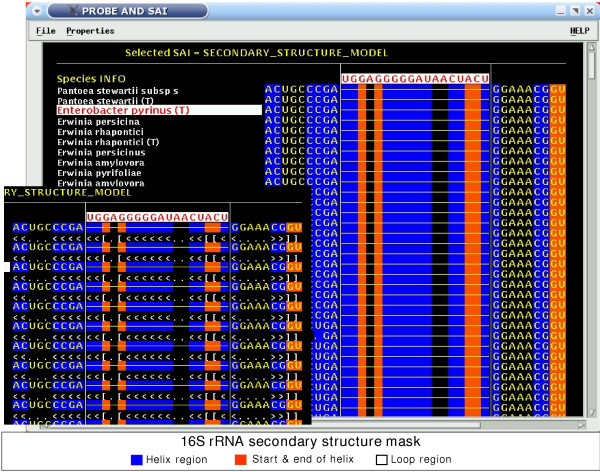
Screenshot displaying 16S rRNA secondary structure model where helix region is colored in blue, starting and ending positions of helix halves are in red and bases without background represent commonly non base paired positions.